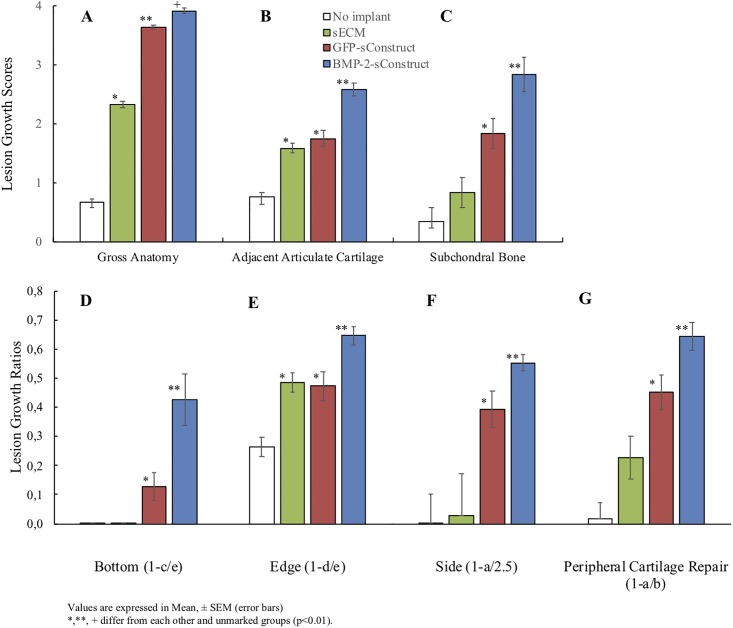
Lesion with sConstruct implants; Growth scores and filling measurements.Gross anatomy (A), articulate cartilage (B), and subchondral bone repair scores (C) and bottom (D), edge (E), sides inwards (F) and peripheral cartilage (G) measurement ratios. Lesion with no implant (white), with sECM (green), GFP-sConstructs (blue) or BMP-2-sConstructs (red).